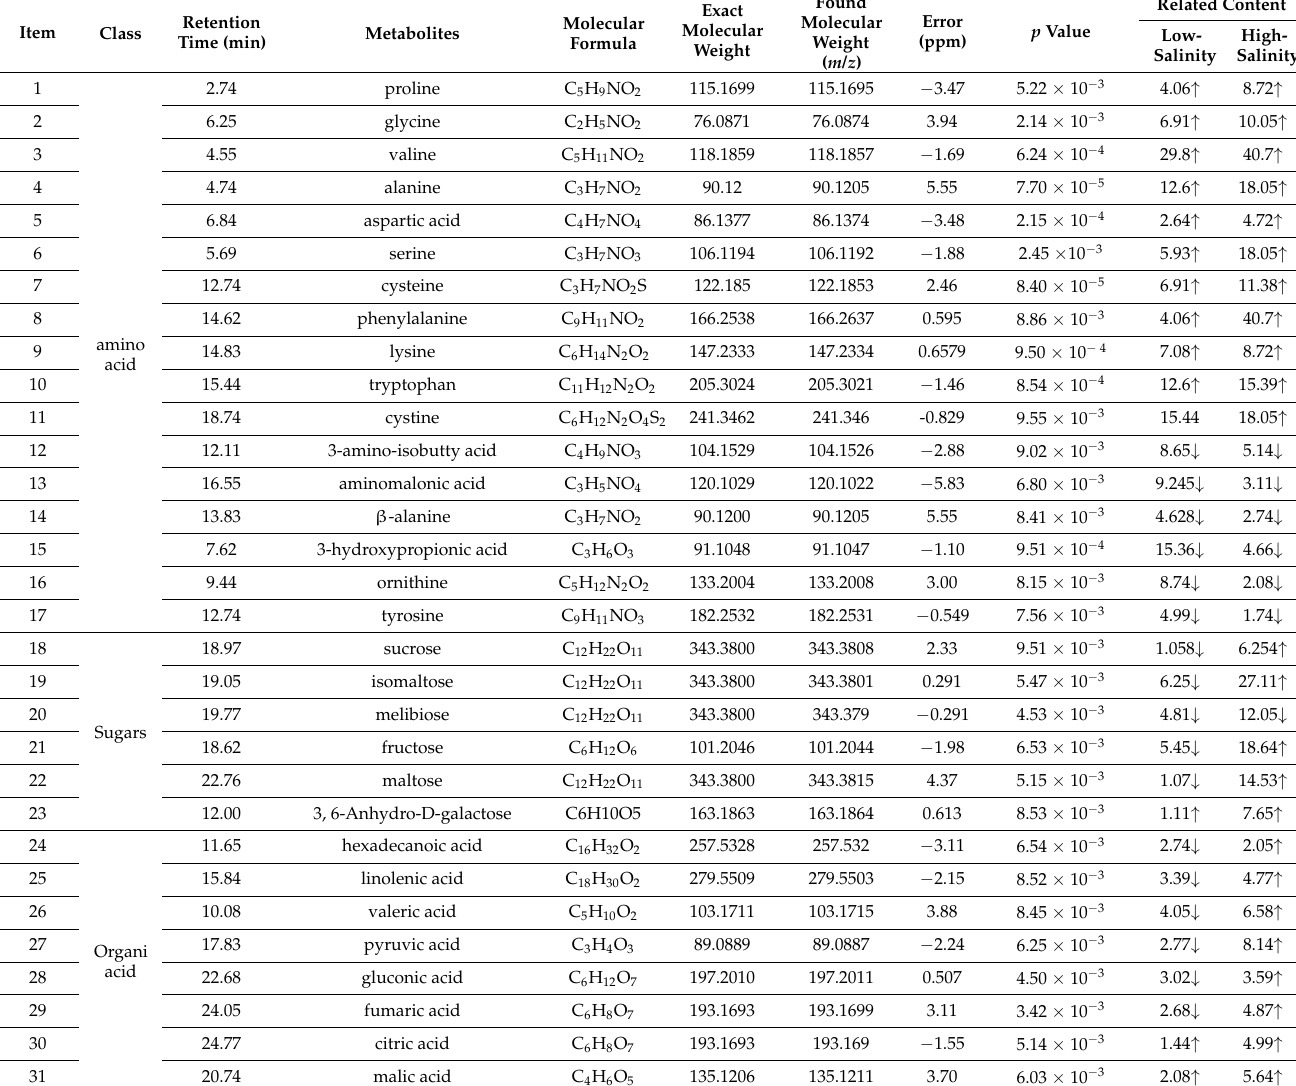
Table 2. The fold change of major metabolites in the storage root between low and high